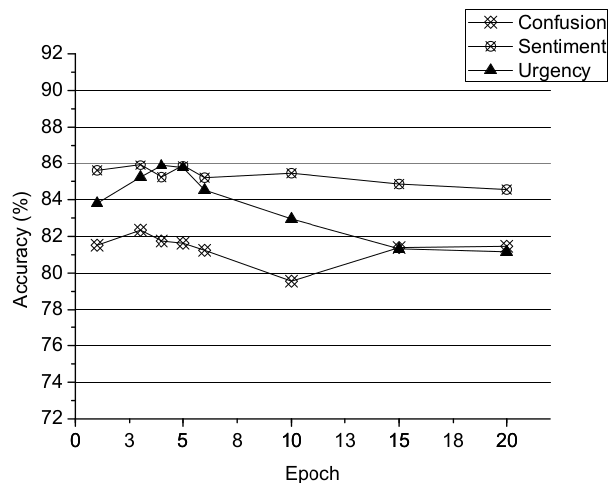
Figure 3. Effect of the S course epoch number.